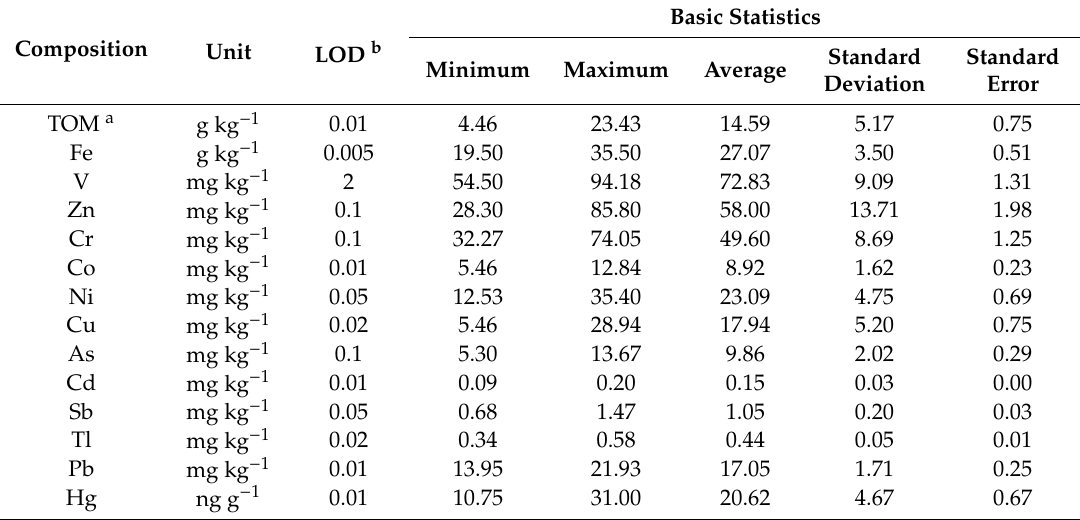
Table 1. Descriptive statistical analysis of major elements and potentially toxic elements in the surface soils of the Bosten Lake